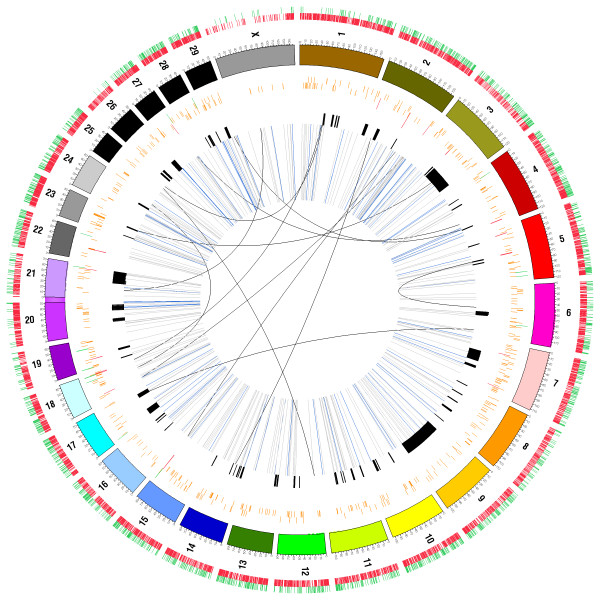
Genomic distribution of structural variation. The innermost circle shows inversions (grey line) and intra and inter-chromosomal translocations (blue and black lines, respectively). Black bars represent IBD regions identified in the bull. The next circle shows a histogram representing deletions (red) and duplications (green) found by at least two of the CNV platforms; CNVs called by only one platform are in orange. The circle outside the ring of solid coloured chromosomes represents the insertions (green) and deletions (red) found by the mate-pair (BreakDancer) and split-pair (Pindel) analyses.